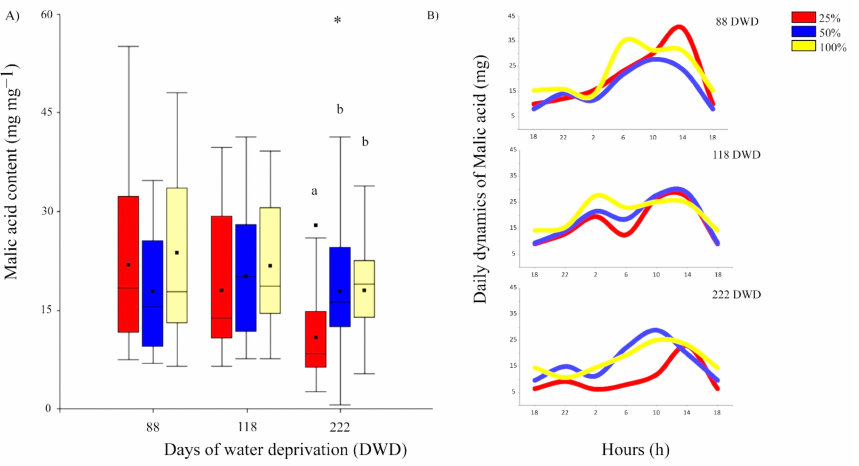
Figure 7. ( A ) Box plots showing the changes in malic acid content in the function of the days under water deprivation (DWD). Asterisk indicates significant differences between DWD at p ≤ 0.05. Different letters indicate significant differences ( p ≤ 0.05) between preconditioning treatments within a given period of water deprivation. ( B ) Changes in daily malic acid evolution at a given interval of time under water deprivation. Lines, dots, and colors of each box correspond to what was previously indicated in Figure